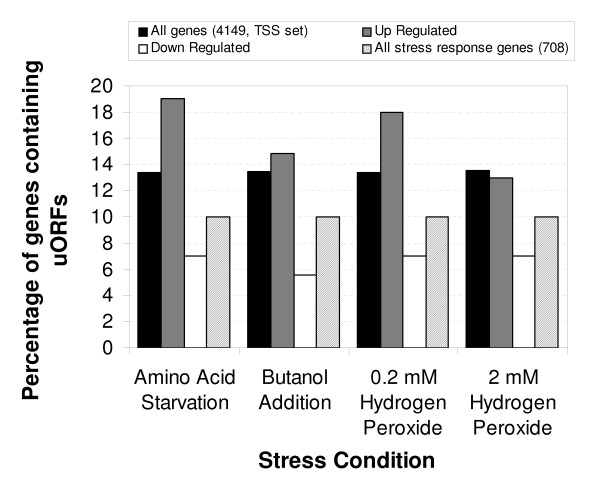
Proportion of uORF-containing genes in translationally controlled gene sets. The fraction of different gene sets whose UTRs contain uORFs are shown for different stress conditions labelled on the x-axis. This is compared to all 4149 TSS-mapped genes and all 708 genes showing differential regulation in any of the 4 stress conditions. A general trend of uORF enrichment is observed in the up-regulated gene sets compared to down-regulated under all stresses. Up and down-regulated genes were excluded from the "All Genes" set.